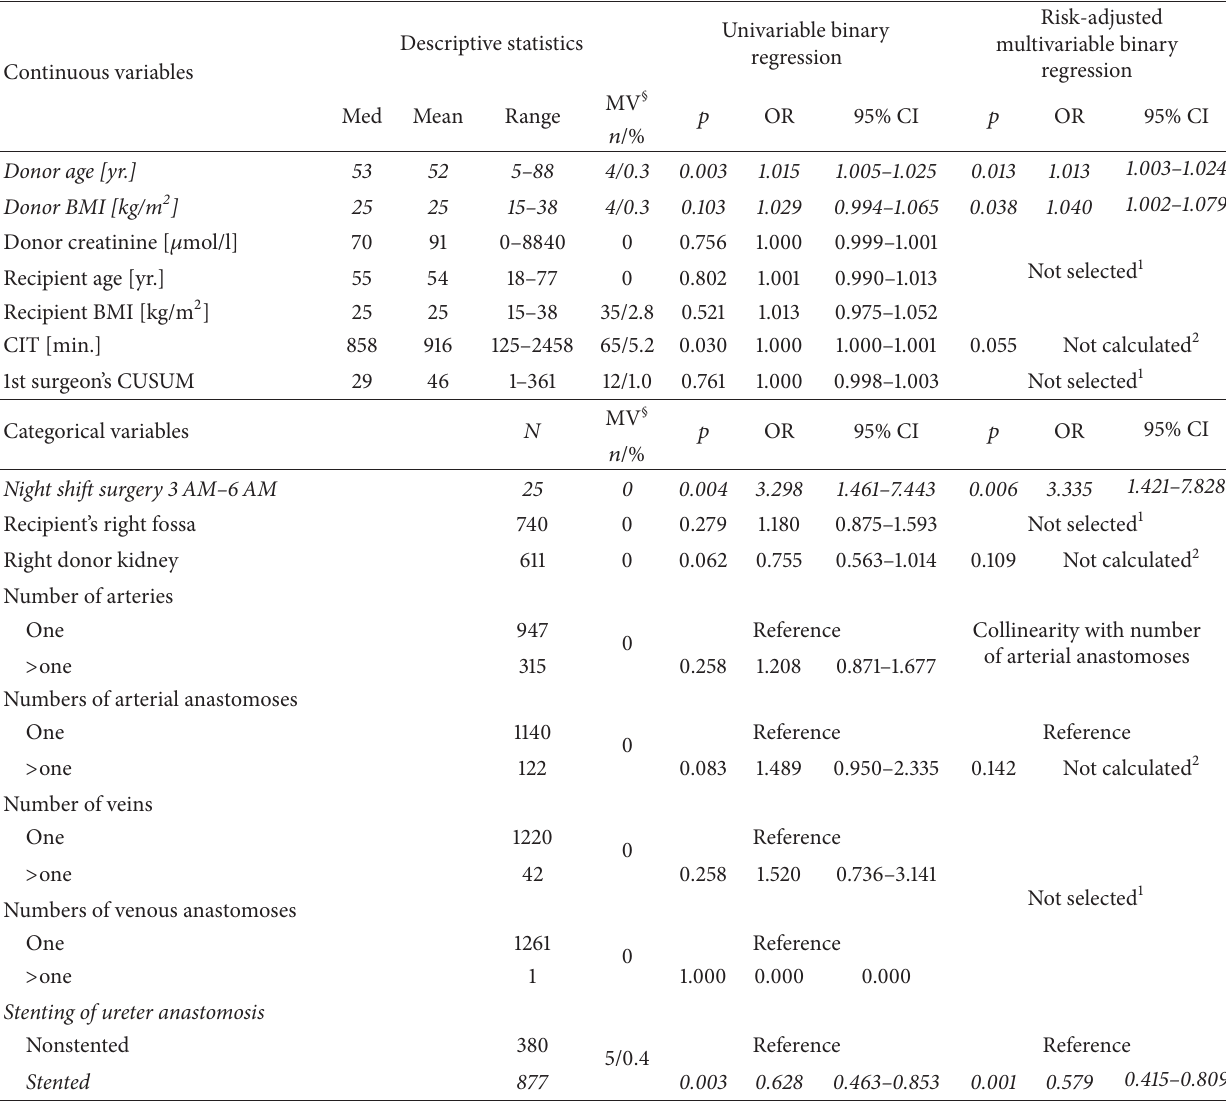
Table 3: Regression analysis of the risks for reoperation ( 𝑛 = 218 ). Shown are the results of univariable and multivariable binary regression analyses to determine the odds ratios of the investigated variables for the risk of reoperation ( 𝑛 = 218 ) during primary hospitalization. Analyzed were all 1262 standard kidney transplants into nonpreoperated sites performed between 1 January 2000 and 31 October 2013. Included into risk-adjusted multivariable analyses were those variables with a 𝑝 value < 0.2 in univariable regression